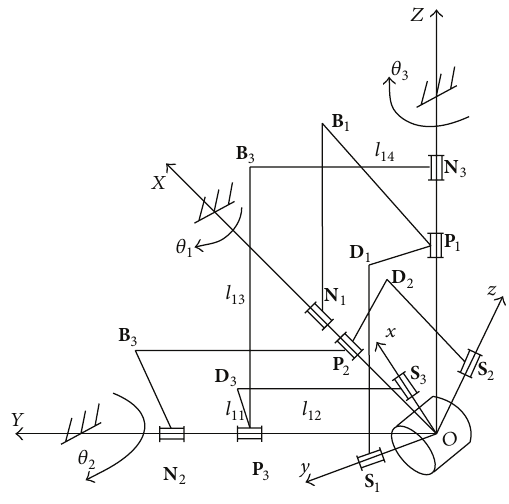
Figure 2: Structure of the hip